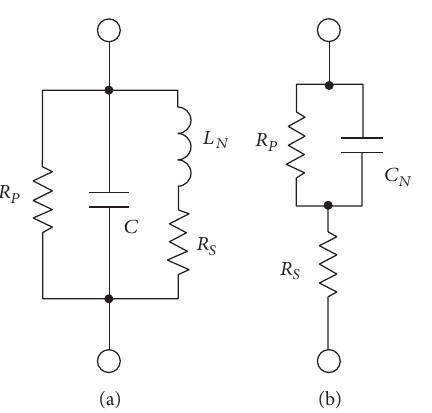
Figure 6: Equivalent circuits (a) for lossy winding of nominal inductance 𝐿 𝑁 and (b) for a lossy voltage-controlled capacitor of nominal capacitance 𝐶 𝑁 .